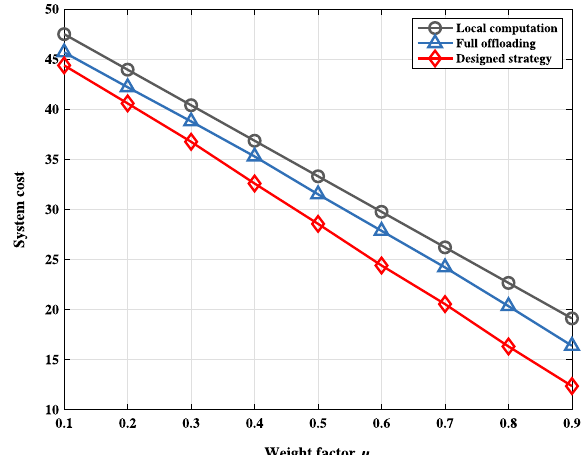
Fig. 5 Impact of the weight factor µ on the system